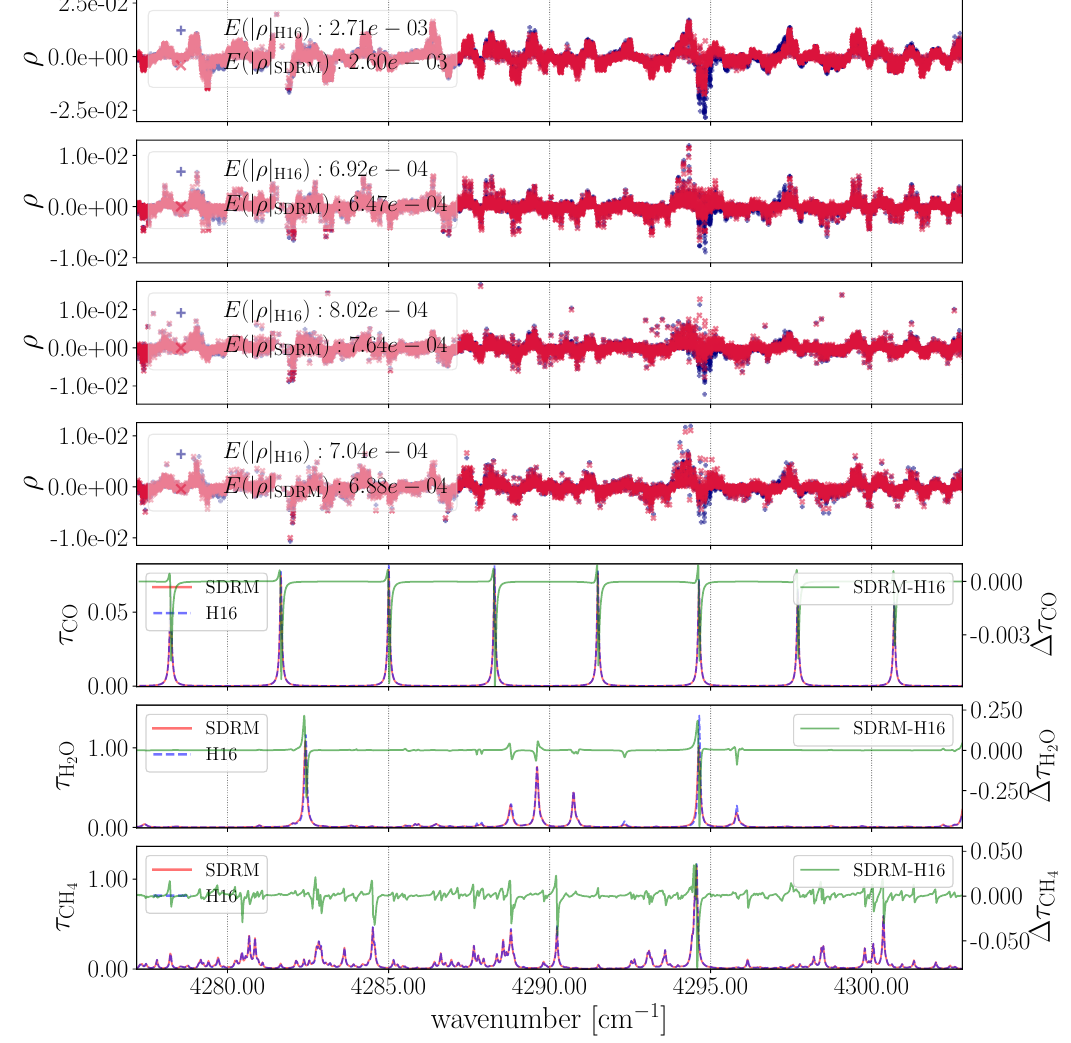
Figure 10. Spectral fitting residuals for TROPOMI observations in the four regions (same order top to bottom as in Figure 9) from the earlier mentioned subset in 2019. Large residuals in the upper four panels reveal to be co-located with strong (and overlapping) absorption lines depicted in the lower three panels. However, similar to Figure 9, the overlapping transitions close to 4295 cm − 1 causes rather less significant fitting errors in the SDRM retrievals. Moreover, compared to H16, the average fitting residual is smaller for SDRM in all of the examined